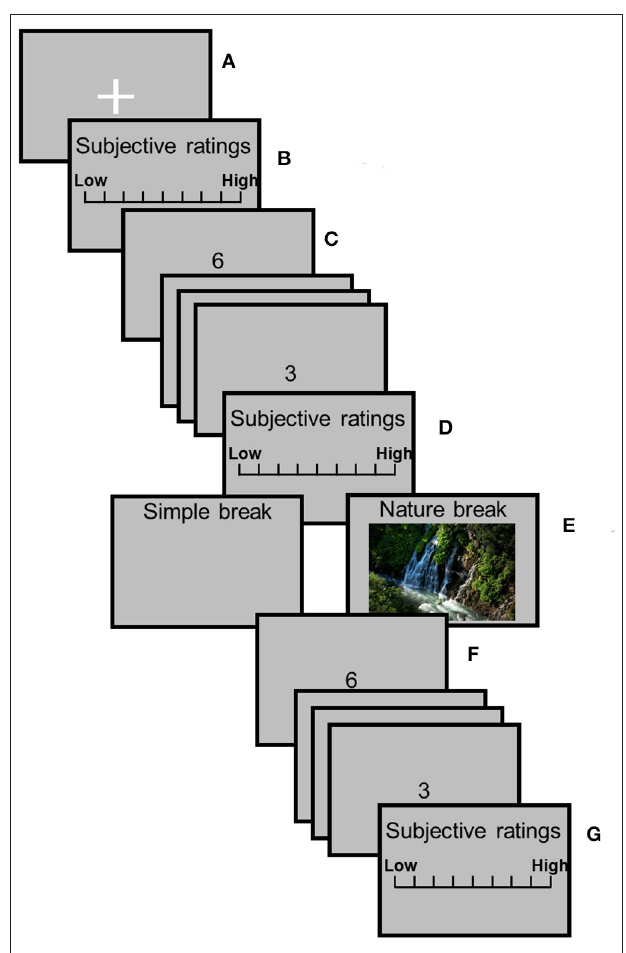
FIGURE 1 | Experimental procedure. (A) Rest session; (B,D,G) subjective rating sessions; (C,F) pre-recovery SART and post-recovery SART sessions; and (E) recovery